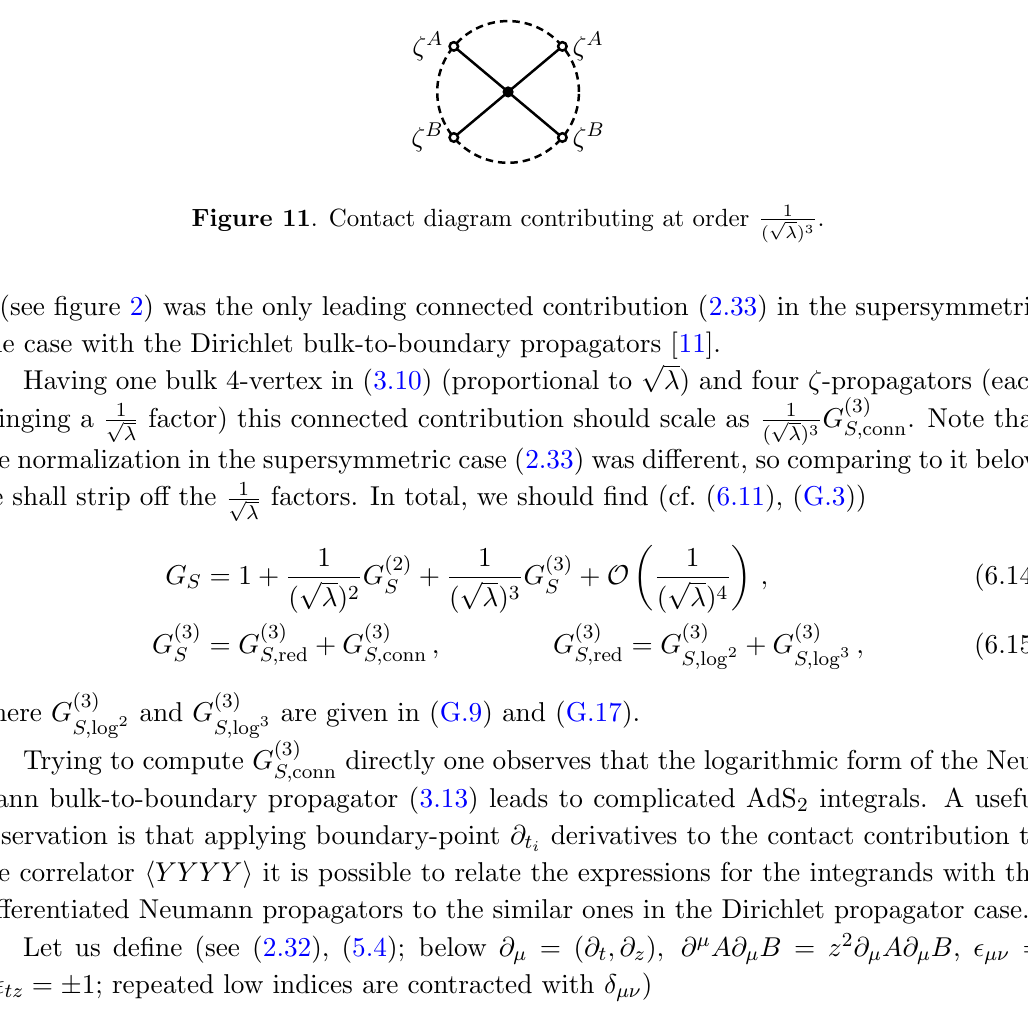
Figure 10 . \Reducible" tree-level diagram contributing at order